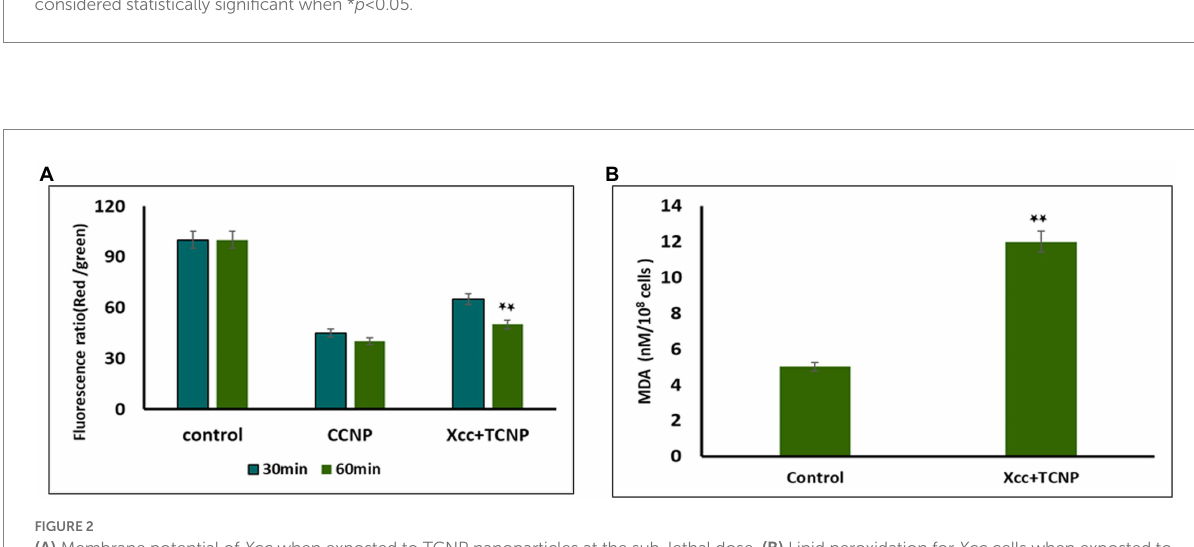
FIGURE 2 (A) Membrane potential of Xcc when exposted to TCNP nanoparticles at the sub-lethal dose. (B) Lipid peroxidation for Xcc cells when exposted to TCNP nanoparticles at the sub-lethal dose. Data are represented as mean ±. S.D. of three independent experiments, each performed in triplicates and considered statistically significant when * p <